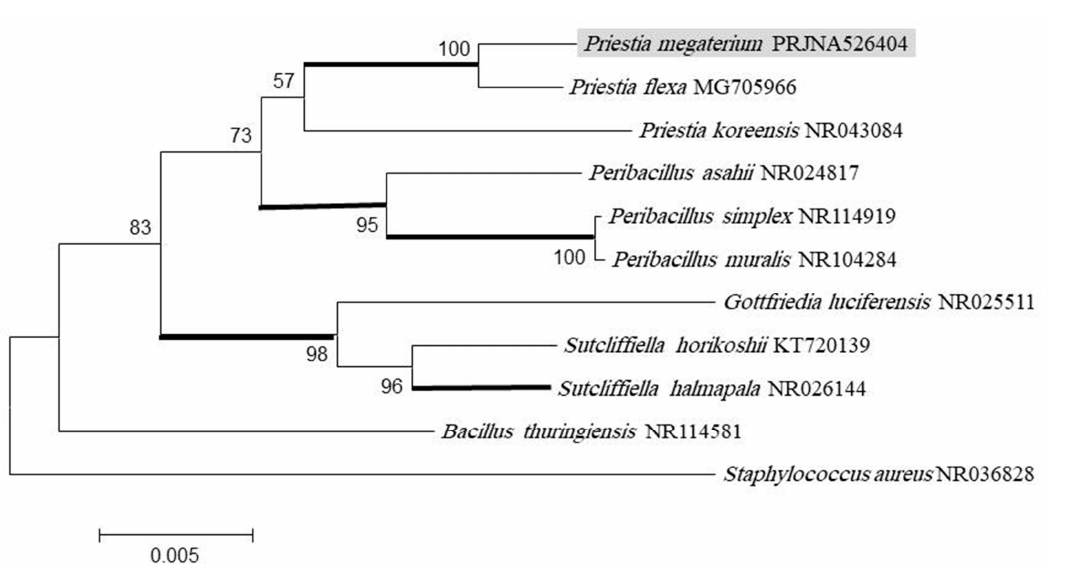
Figure 1. Phylogenetic relationships of Priestia megaterium and four of the same species retrived from Gen Bank and related species and genera in the family Bacillaceae on the nucleotide sequences of LSU rDNA. The strain used in the present study is highlighted. The maximum likelihood tree (ML) was constructed in MEGA6. The numbers indicate pp values ≥ 95 % (in bold), MP, ML and MP bootstrap values ≥ 70.